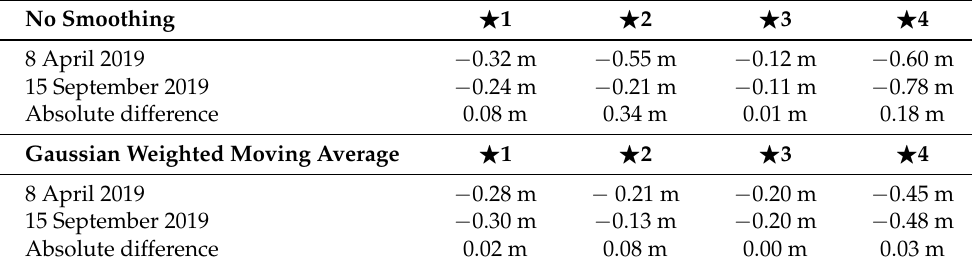
Table 3. Comparison of bathymetry derived from crossovers from two different tracks. The bathymetry is given as heights above the EGM2008. Two different methods were used to derive the bathymetry at the crossover positions.